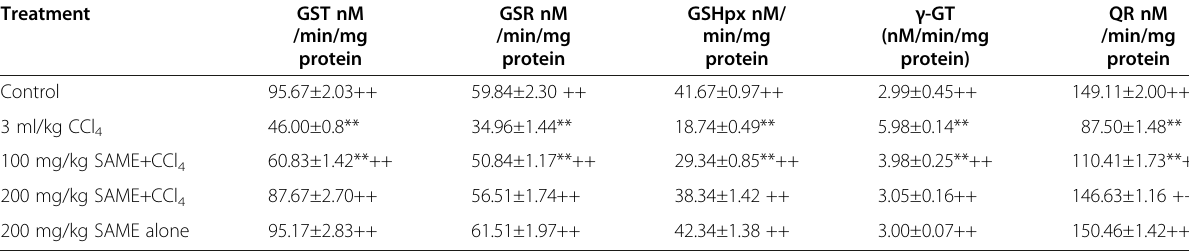
Table 3 Effect of SAME on thyroid GST, GSR, GSHpx, GGT, QR Treatment